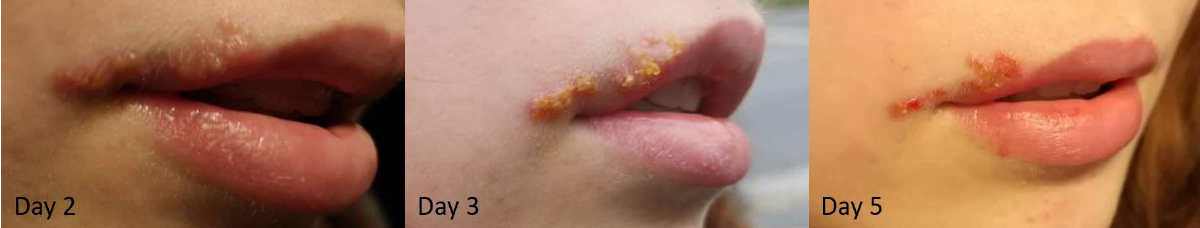
Figure 1. Example of the development of a cold sore, from the vesicular stage ( left ) to blister burst and drying out ( center ) to scab formation ( right ).